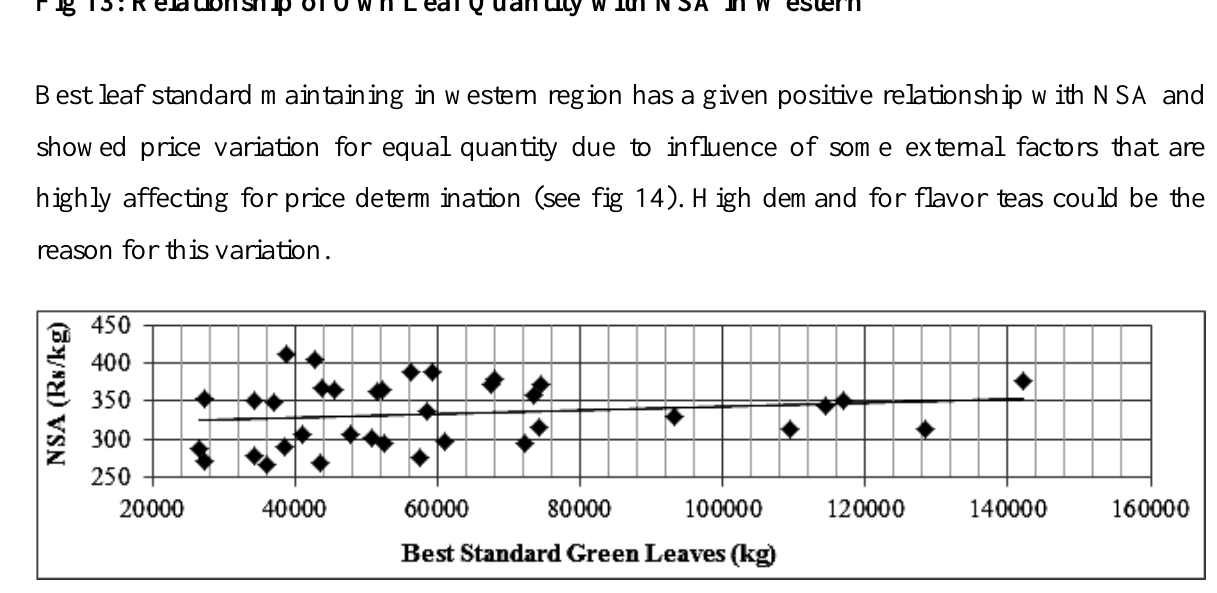
Fig 14: Relationship of Best Leaf Quantity with NSA in